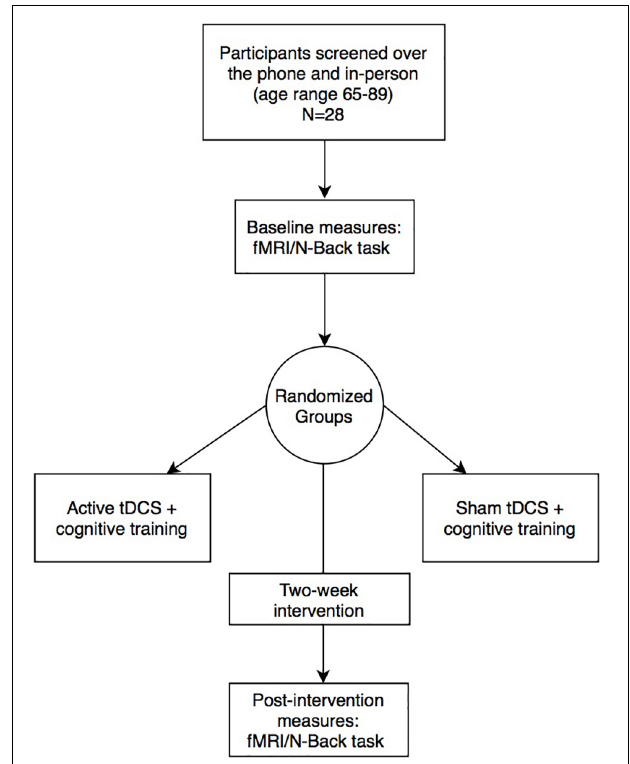
FIGURE 1 | Experimental design and study